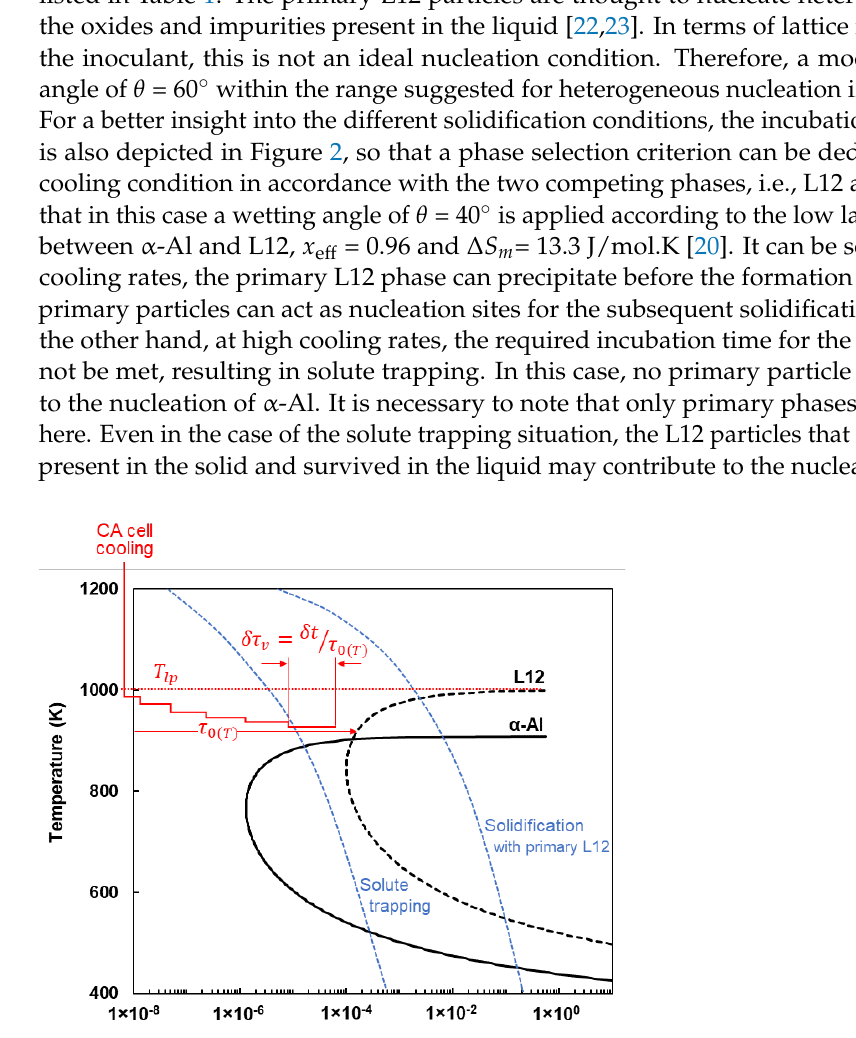
Table 1. Parameters used in the TTT model for the initiation criterion of L12 precipitation.